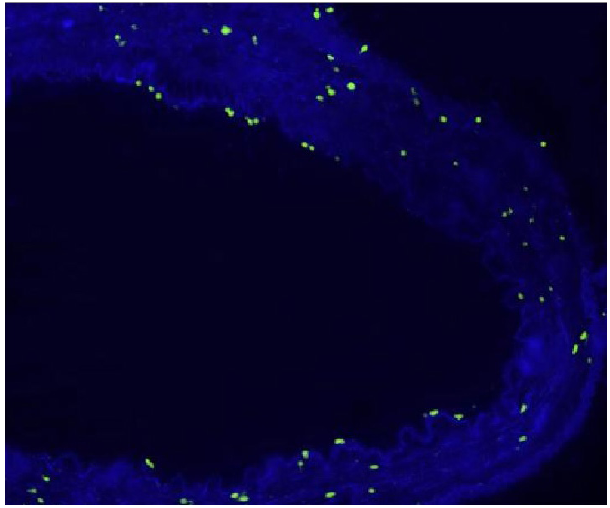
Fig. 2D – Terminal deoxynucleotidyl transferase-mediated dUTP- biotin nick end labeling (TUNEL) stain of an artery in the papaverine group (Group